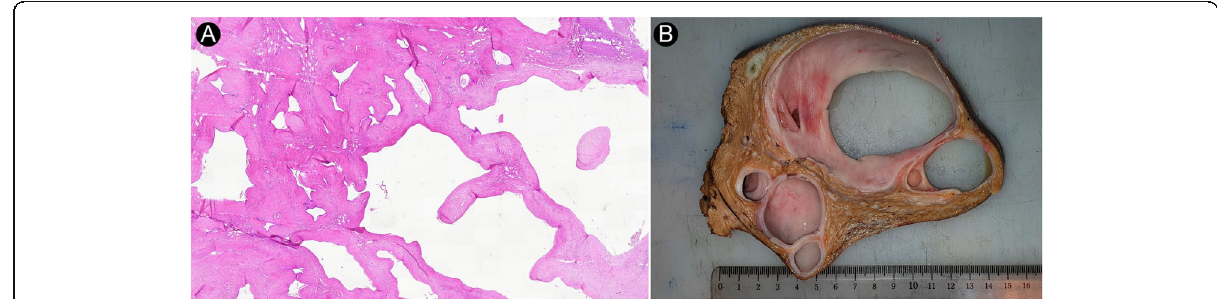
Fig. 3 Cystic change in HMH. A Histopathologic section from HMH showing cystic change (Hematoxylin and Eosin, 20×). B Cut section of HMH with extensive cystic